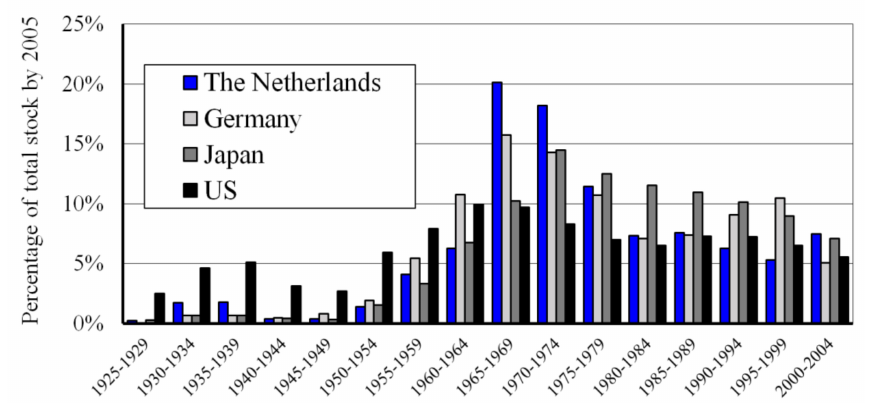
Figure 1. Historical overview of built bridges in Japan [2], the US [3], Germany [4], and the Netherlands [5].